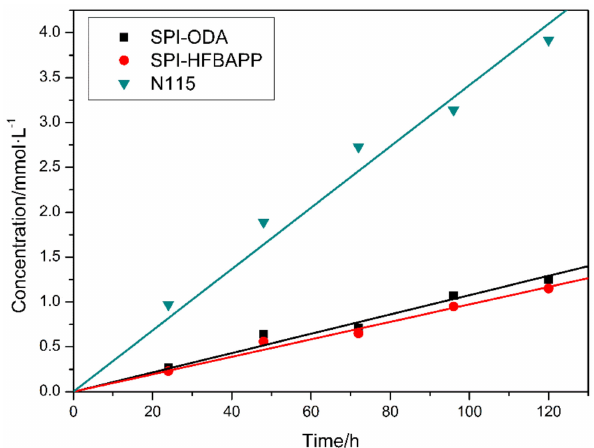
Figure 3. The vanadium ion concentration changes in MgSO 4 solution across SPI and N115